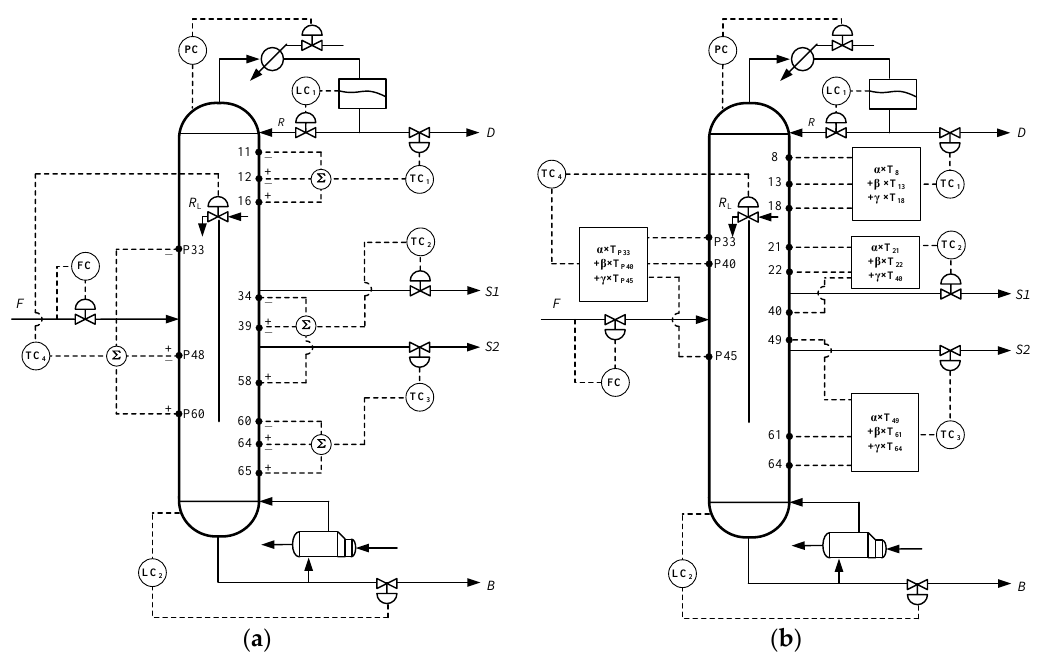
Figure 10. Two temperature inferential control schemes studied (Example II): ( a ) DTDC scheme; ( b ) TC-PQE scheme.